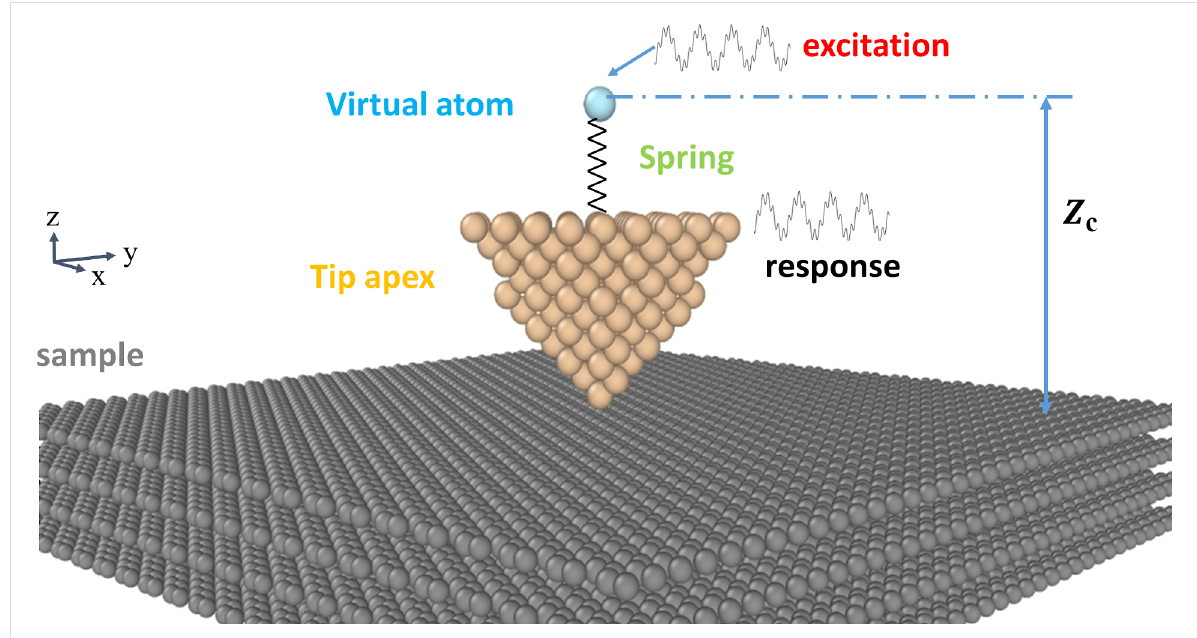
Figure 1: Snapshot of the AM mode molecular dynamics simulation. Z c is the distance between the virtual atom at rest and the sample surface. The dynamic response of the tip is determined by the excitation of the virtual atom and tip–sample interactions. In the simulation the tip is parallel to the sample surface and the scanning is done in raster scan